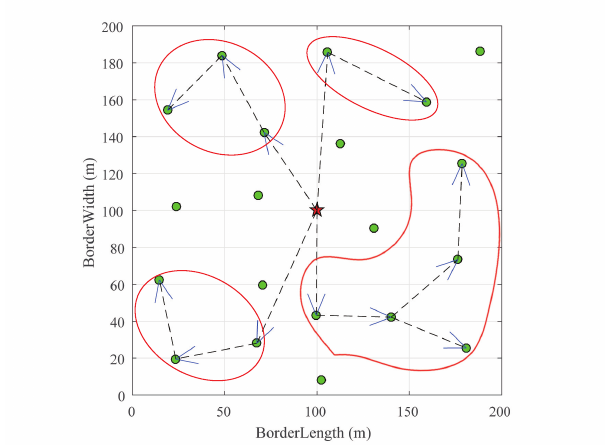
Figure 2. A diagram form of data 1’s allocation and transmission under coalition game